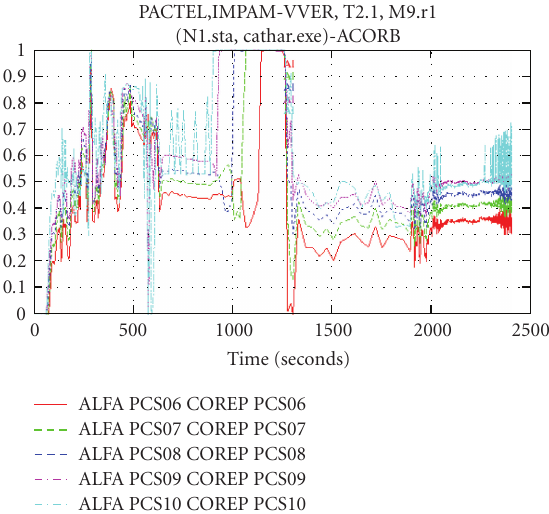
Figure 8: Primary and secondary pressures.